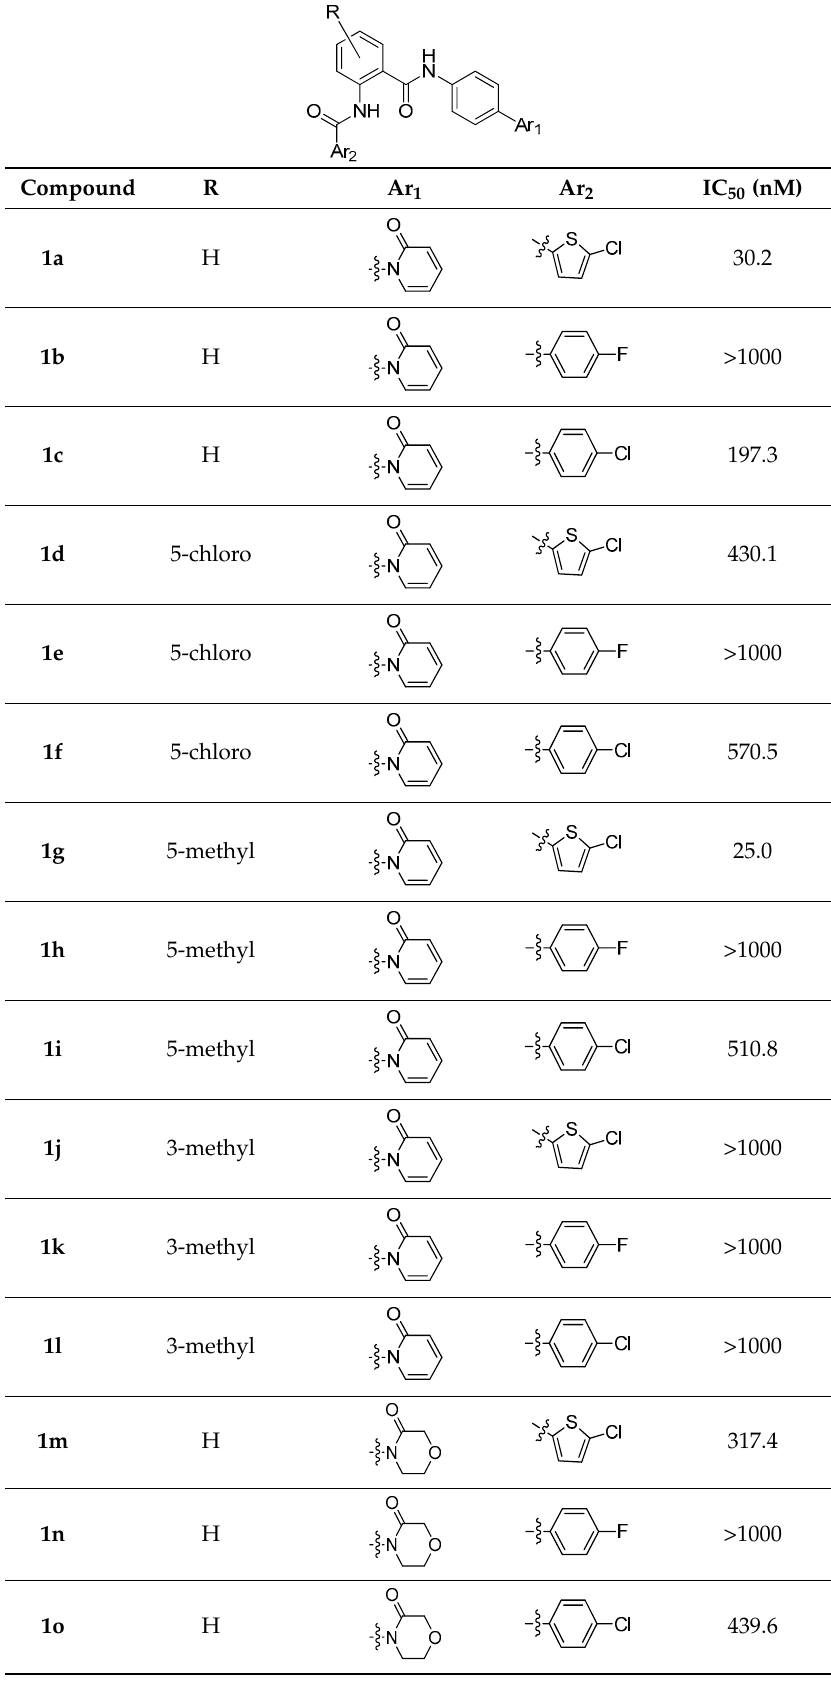
Table 1. The structures of the target compounds 1a – 1x and their biological activity evaluation.